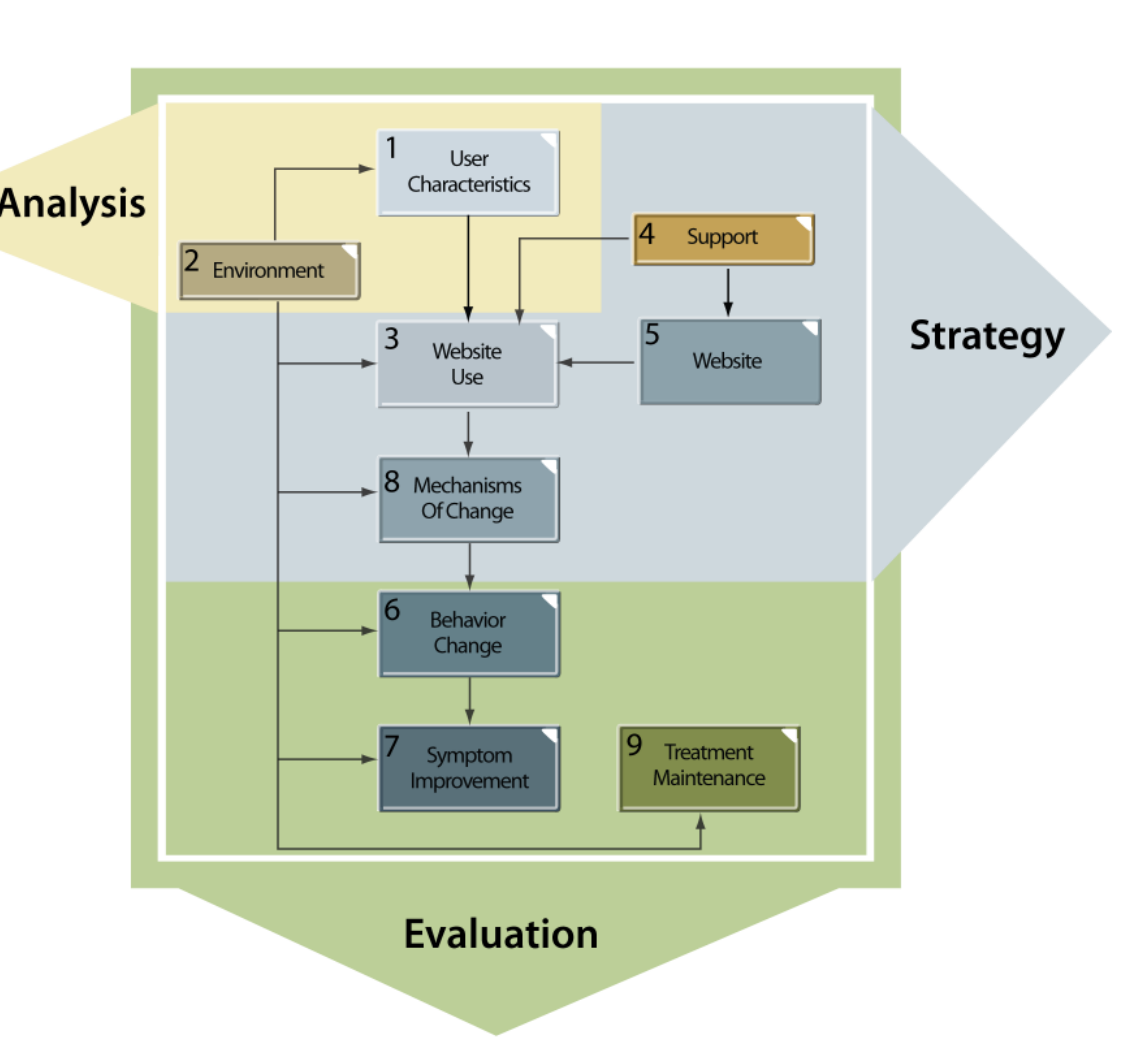
Figure 3. Instructional design process model for behavior change in Internet